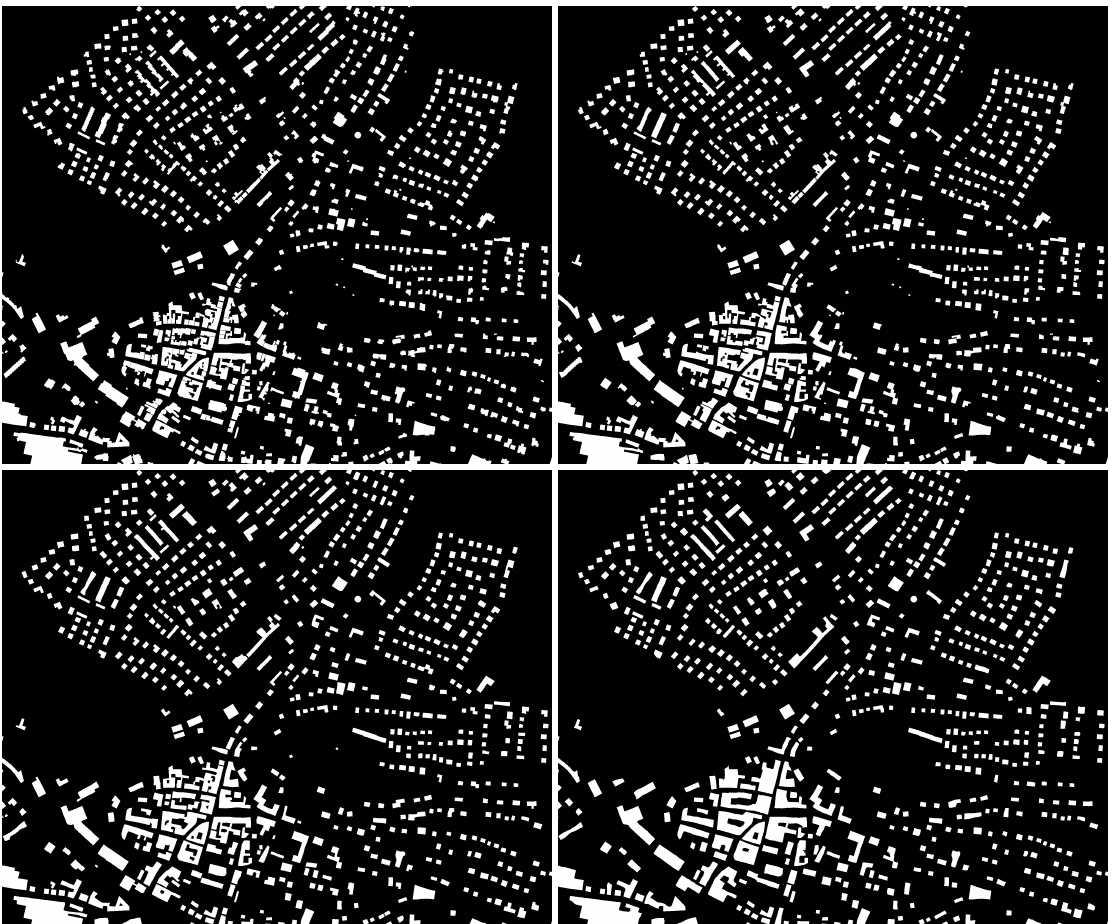
Figure 16. Original map scale ( upper left ), generalization results from residual U-net at map scales 1:10,000 ( upper right ), 1:15,000 ( bottom left ) and 1:25,000 ( bottom right )—residential and industrial buildings, inner